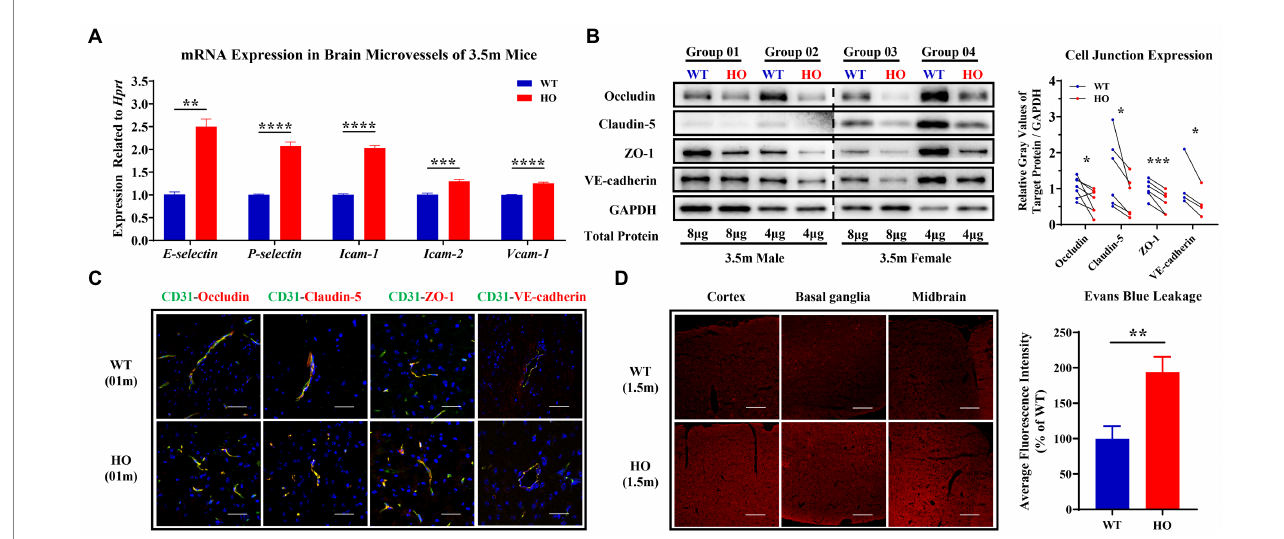
FIGURE 2 Expression and distribution pattern of core adhesion molecules and junction proteins and the blood–brain barrier (BBB) permeability of paracellular pathway. (A) The relatively increased expression of selectin and cell adhesion molecules (CAMs) in brain microvessels of 3.5-month-old Slc20a2 -HO compared to that of -WT mice ( n = 3 pairs). (B) Decreased protein expression of TJs (occludin, claudin-5, and ZO-1) and AJ (VE-cadherin) in brain microvessels of 3.5-month-old -HO compared to that of -WT mice. (C) No difference in localization, morphology, and polarization of TJs and AJ proteins in 1-month-old -WT and -HO mice. Brain microvessels visualized by CD31. (D) Evans blue have slightly increased entry into the brain parenchyma of -HO compared to -WT mice at the age of 1.5 months. Scale bars, 40 μ m (C) , 80 μ m (D) . **** p < 0.0001; *** p < 0.001; ** p < 0.01; * p < 0.05.